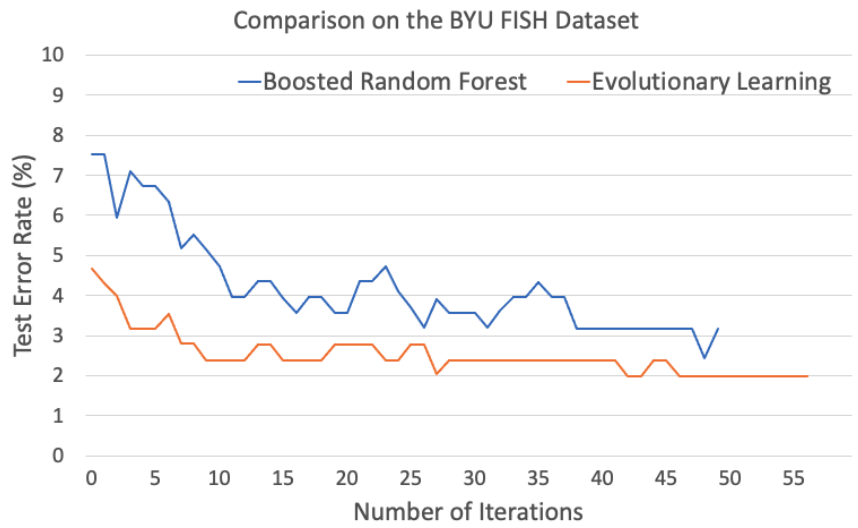
Figure 9. Performance comparison on the BYU Fish dataset between the boosted random forest method and the evolutionary learning method with respect to different numbers of training iterations.